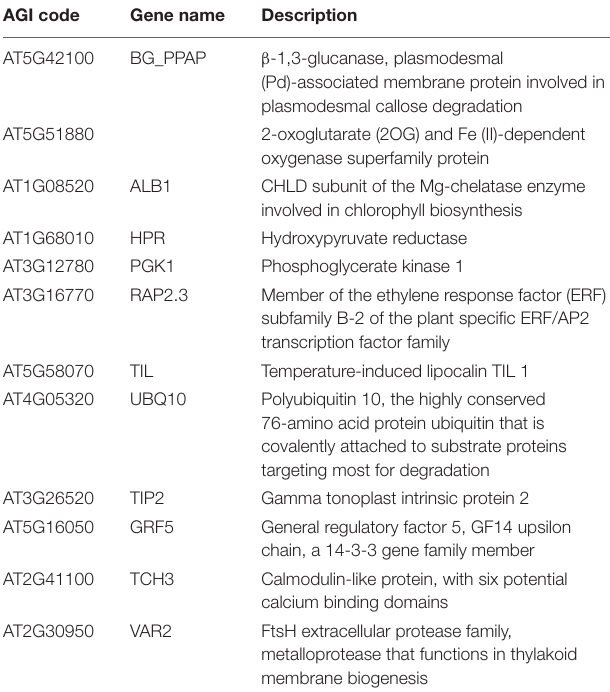
TABLE 1 | Potential ORA59 interactors identified in the Y2H